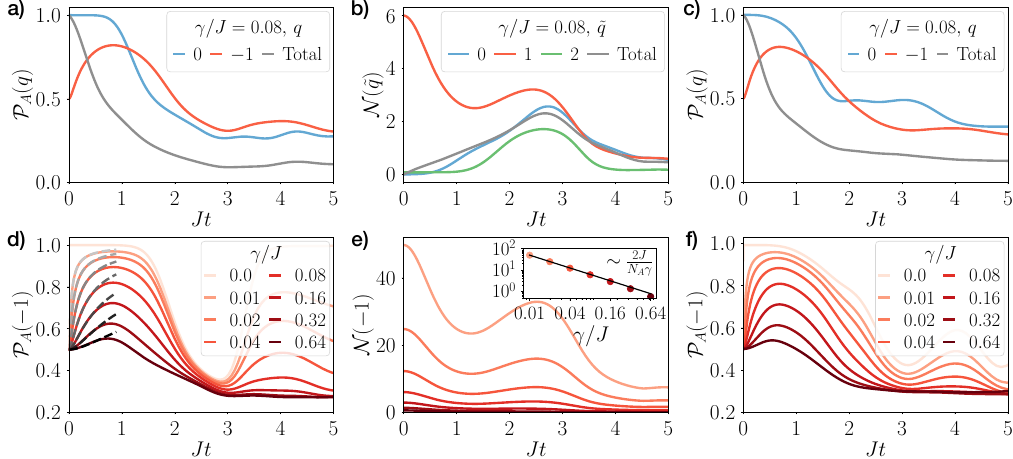
Figure 4: Dynamical purification and symmetry-resolved entanglement for one- dimensional XY spin models. We choose a system with N = 8, initialized in a Néel ⊗ N / 2 state |↓↑〉 and evolved with H subject to particle loss with rate γ (see main XY text). We take A = [ 1,2,3,4 ] and B = [ 5,6,7,8 ] . In panels (a,b,d,e), we consider = J δ short-range interactions J and vanishing disorder δ/ J = 0. We present ij i − 1, j ( q ) [ panels (a,d) ] and the normalized symmetry- the symmetry-resolved purity P A ( ˜ q ) [ panels (b,e) ] for various imbalance sectors ˜ q (a,b) and resolved negativity N ( − 1 ) | decoherence rates γ (d,e). The inset in (e) shows the early time value as t = 0 + N function of γ/ J . In panels (c,f), we present the symmetry-resolved purity for various imbalance sectors (c) and decoherence rates (f) in a system with long-range interac- ∼ J / | i − j | 1.2 and a fixed disordered longitudinal field, sampled uniformly tions J ij from [ − δ , δ ] with δ/ J = 0.86. Gray lines in (d,e) are results from perturbation theory, Eqs. (46) and (32),